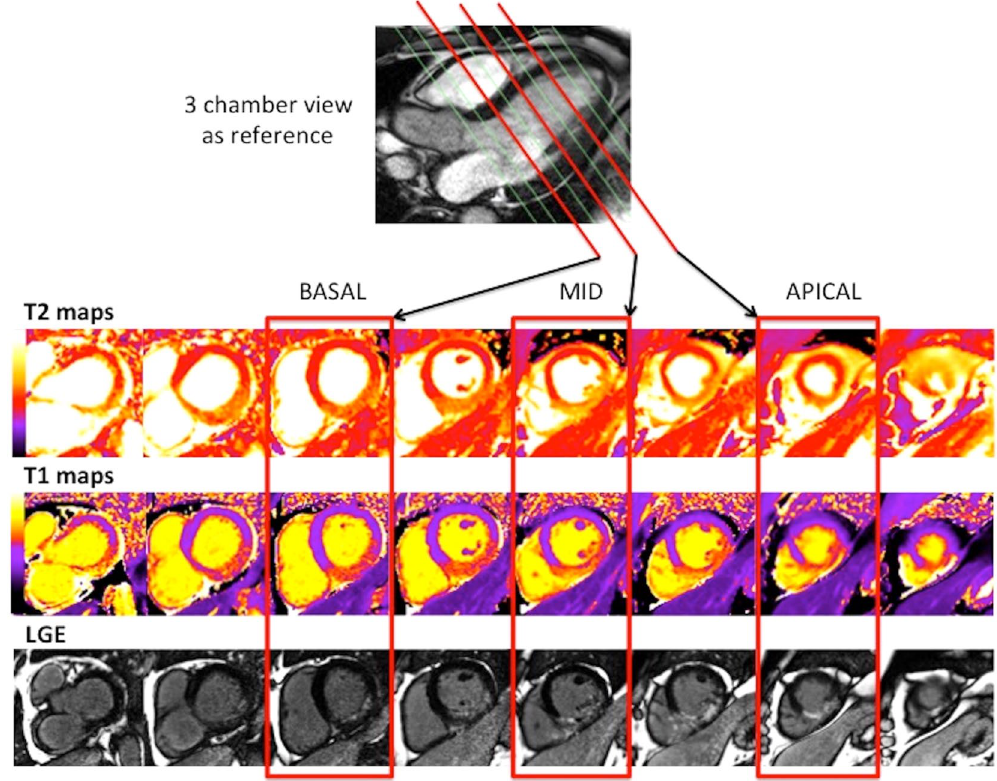
Figure 6. Matching T2 maps, T1 maps and LGE images of a patient with an inferior STEMI. This figure shows the selection of 3 slices (basal, mid and apical) of T2 maps, T1 maps and LGE images from the full LV coverage images of a patient with an inferior STEMI, and with the 3-chamber view as